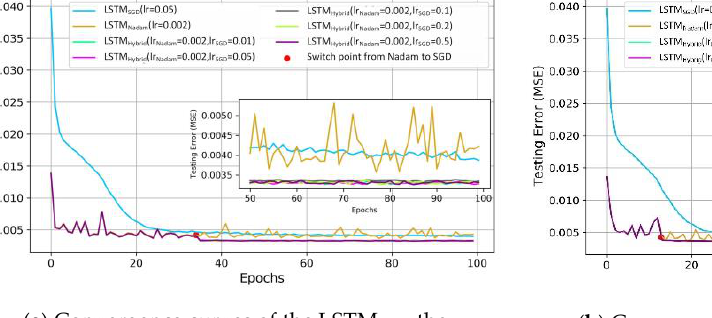
( b ) Convergence curves of the LSTM SGD , the LSTM Nadam and the LSTM Hybrid models (lr Nadam = 0.001).